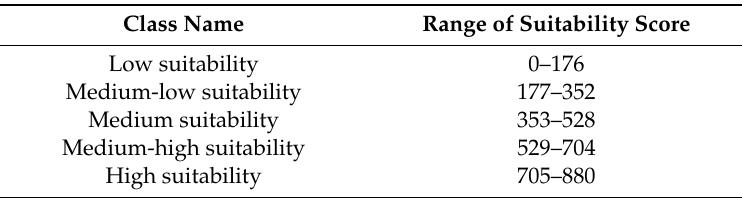
Table 3. Five classes for weighted land suitability